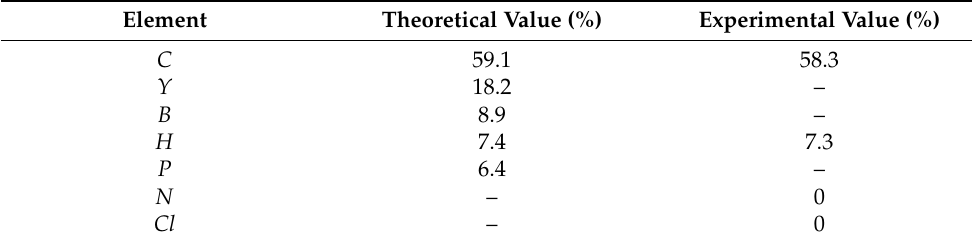
Figure 5. Comparison of IR absorption spectrum of the sample 2 comprising [Ph 4 P][Y(BH 4 ) 4 ] (top, blue line) and a reference spectrum of [Ph 4 P][Dy(BH 4 ) 4 ] obtained in a classical mechanochemical method (bottom, black line) [22]. Table 3. Comparison of theoretical elemental composition of [Ph 4 P][Y(BH 4 ) 4 ] with the results of elemental analysis (C, H, N, Cl) of the product sample 2 .